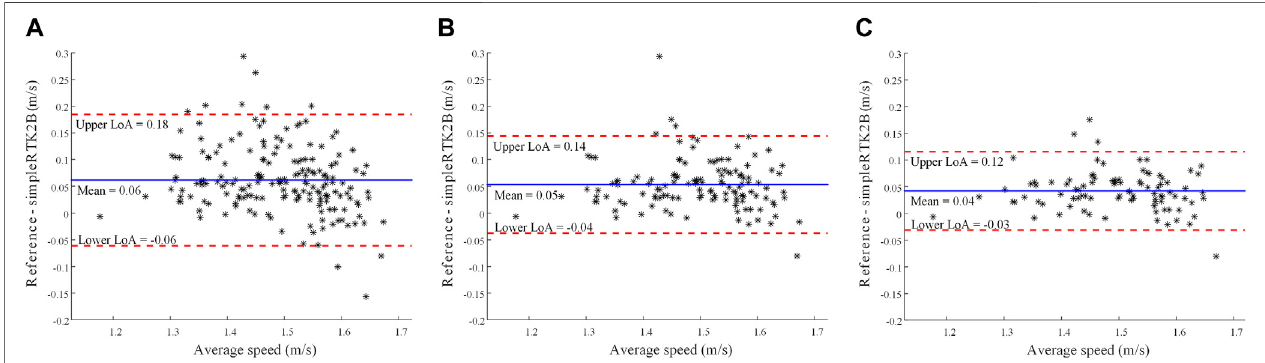
FIGURE 7 | Bland-Altman plots considering all tracts (A) , tracts with < 50% DGPS solutions (B) , and tracts with < 25% DGPS solutions (C) . The mean difference and the upper and lower limits of agreements (LoA) are reported.